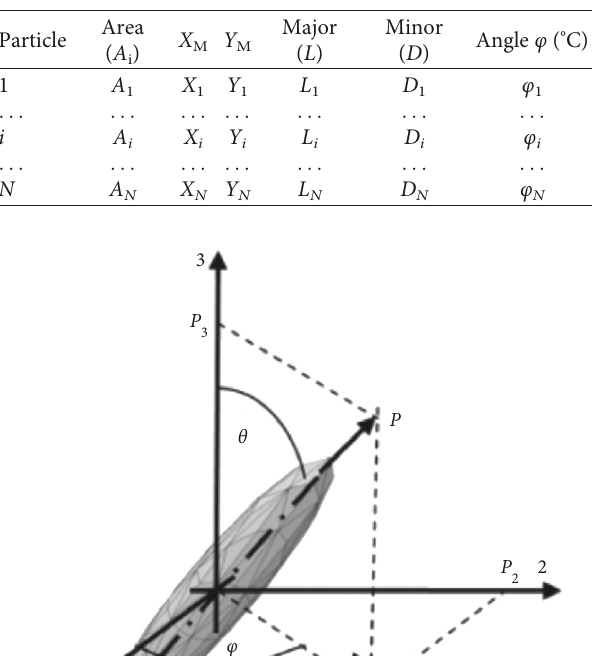
Figure 5: Particle orientation [19].